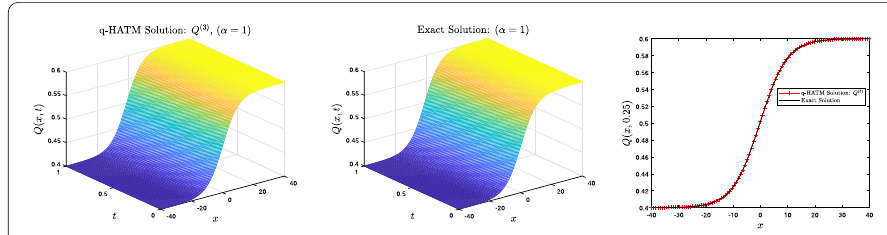
Figure 7 q-HATM vs exact solution when (cid:2) = –1, k = r = 0.1, λ = 1.5, and n = 1 for Example 4.2